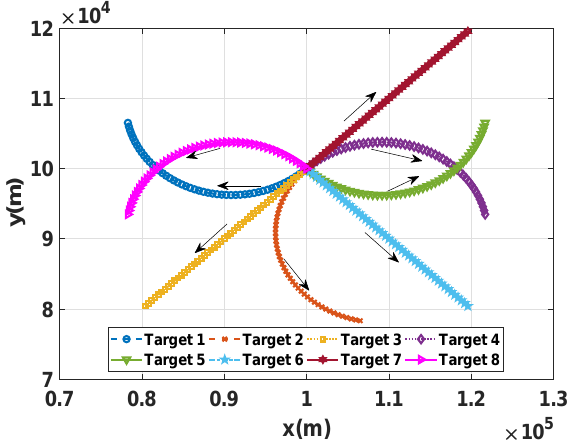
Figure 4. Real moving trajectories of